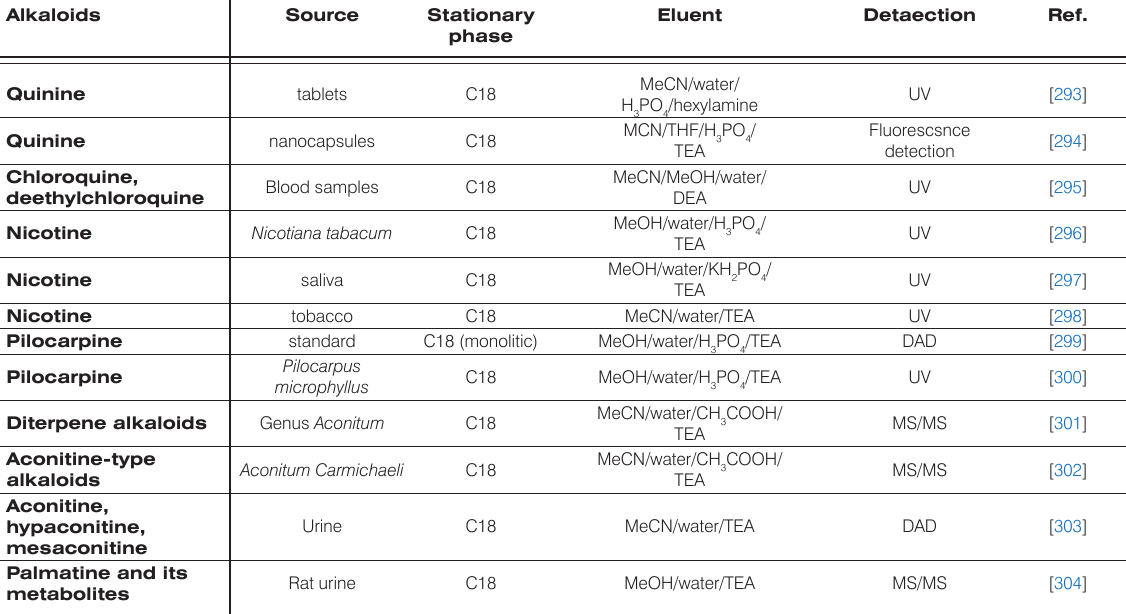
Table 4. Methods used for HPLC of alkaloids with mobile phase containing ion-pairing